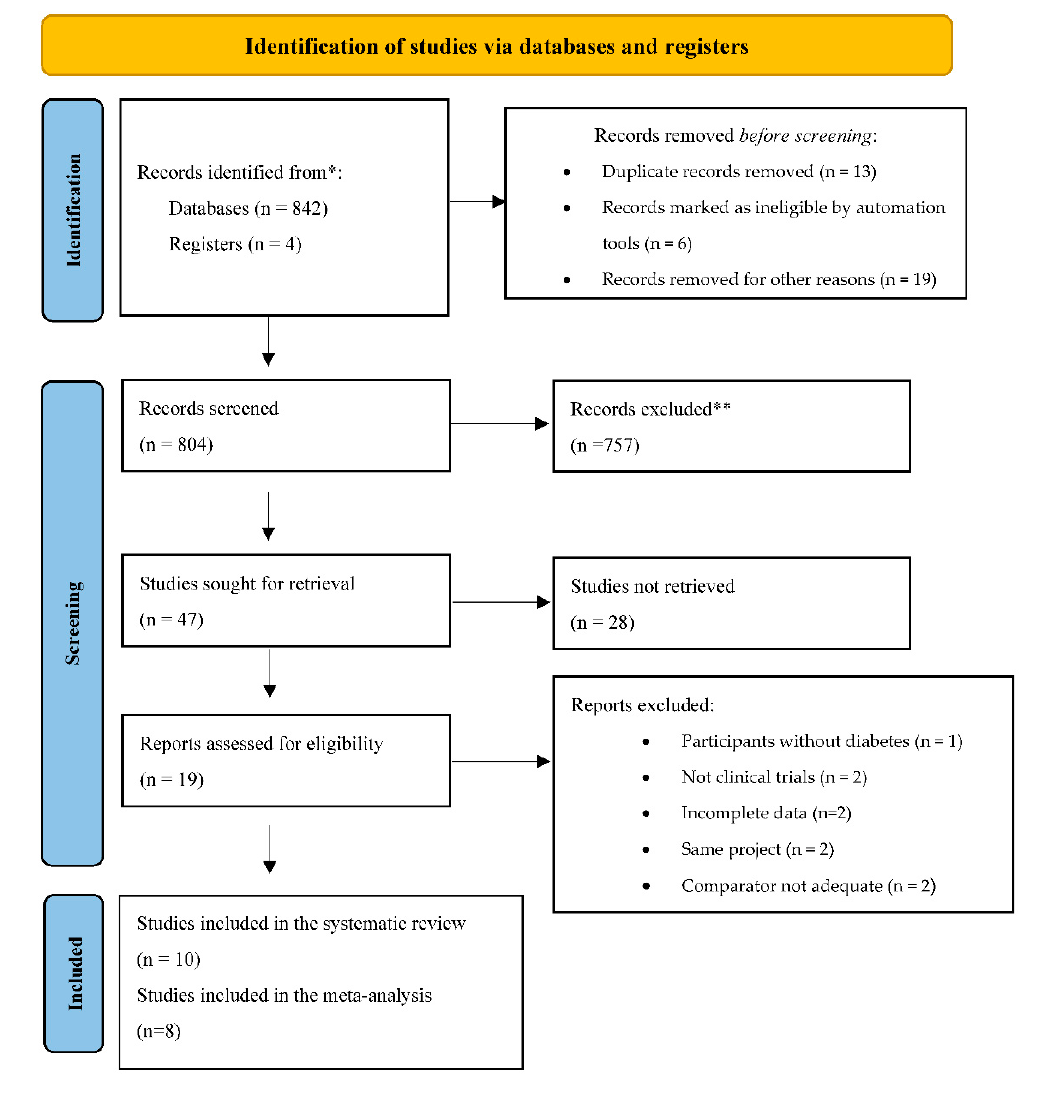
Figure 1. PRISMA Flow Diagram. PRISMA 2020 flow diagram for new systematic reviews that include searches of databases and registers only. * Databases: MEDLINE (589), SCOPUS (136), COCHRANE (117). ** Automation tools were used; 228 records were excluded by a human, and 529 were excluded by automation tools applying filters (humans, clinical trial, age, and year of publication) Records were eliminated if they did not meet the inclusion criteria. Records removed for other reasons (e.g., language, ineligible reading). Studies not retrieved: text publications of articles that appeared to meet the eligibility. Registers: any additional records identified through reference lists.